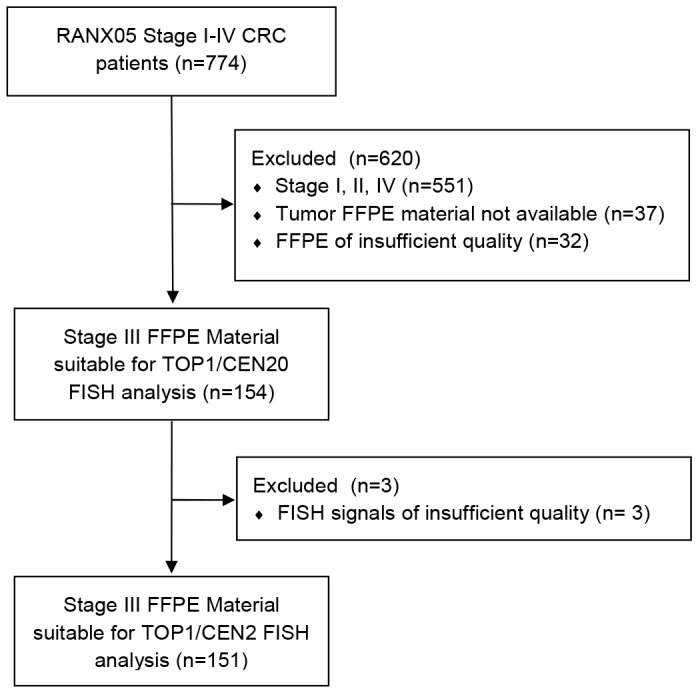
CONSORT flow diagram describing the selection method of samples included in this study.